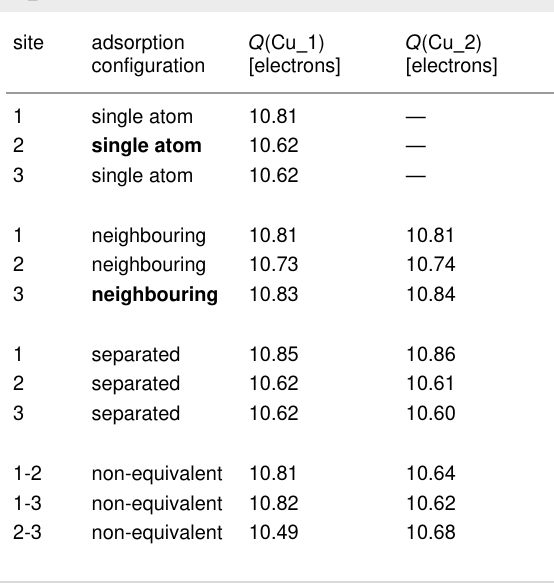
Table 4: Computed Bader charge ( Q ) on each Cu atom for Cu_1 and Cu_2. site